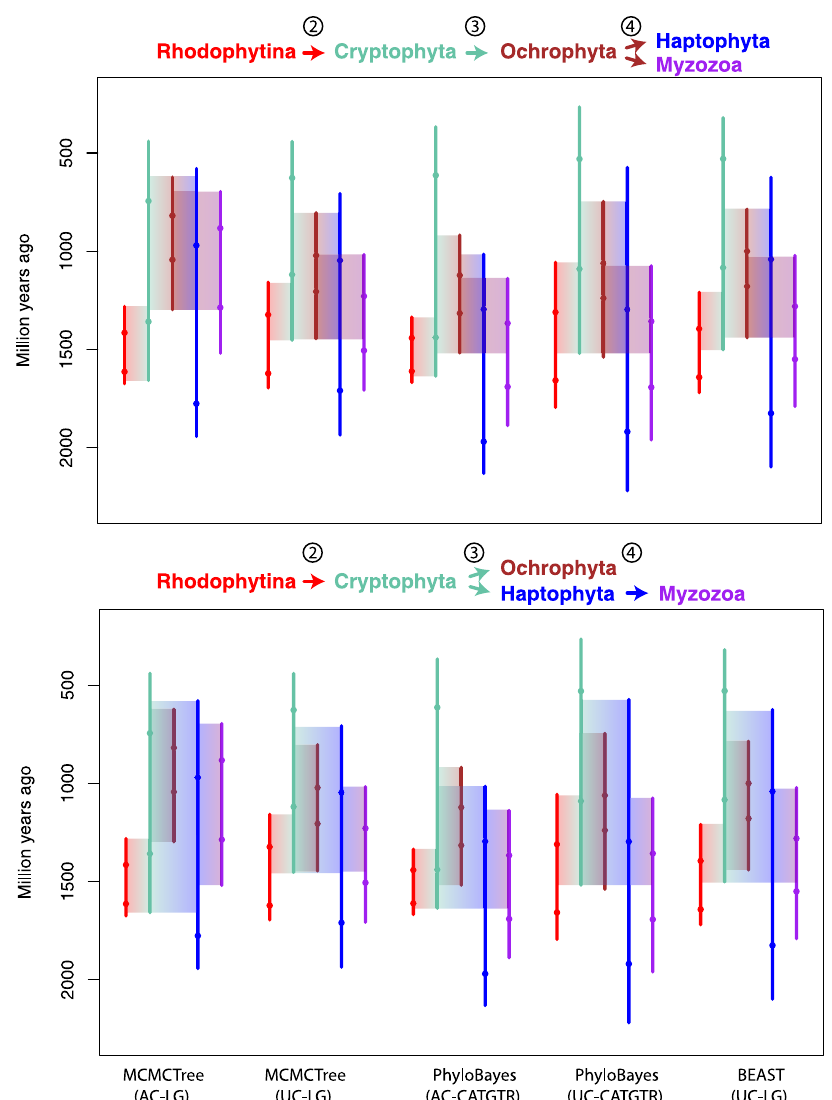
Fig. 4 Summary of inferred timeframes for the spread of complex red plastids using different software and models. Vertical lines correspond to the lower and upper 95% HPD intervals from the nodes de fi ning the branch of interest and dots indicate their posterior mean divergences. Faded boxes represent the temporal windows for the secondary endosymbioses, constrained by the 95% HPDs and tree topology under the two proposed symbiotic scenarios. Numbers at arrows denote the level of endosymbiosis events (compare with Fig. 1). AC autocorrelated clock model, UC uncorrelated